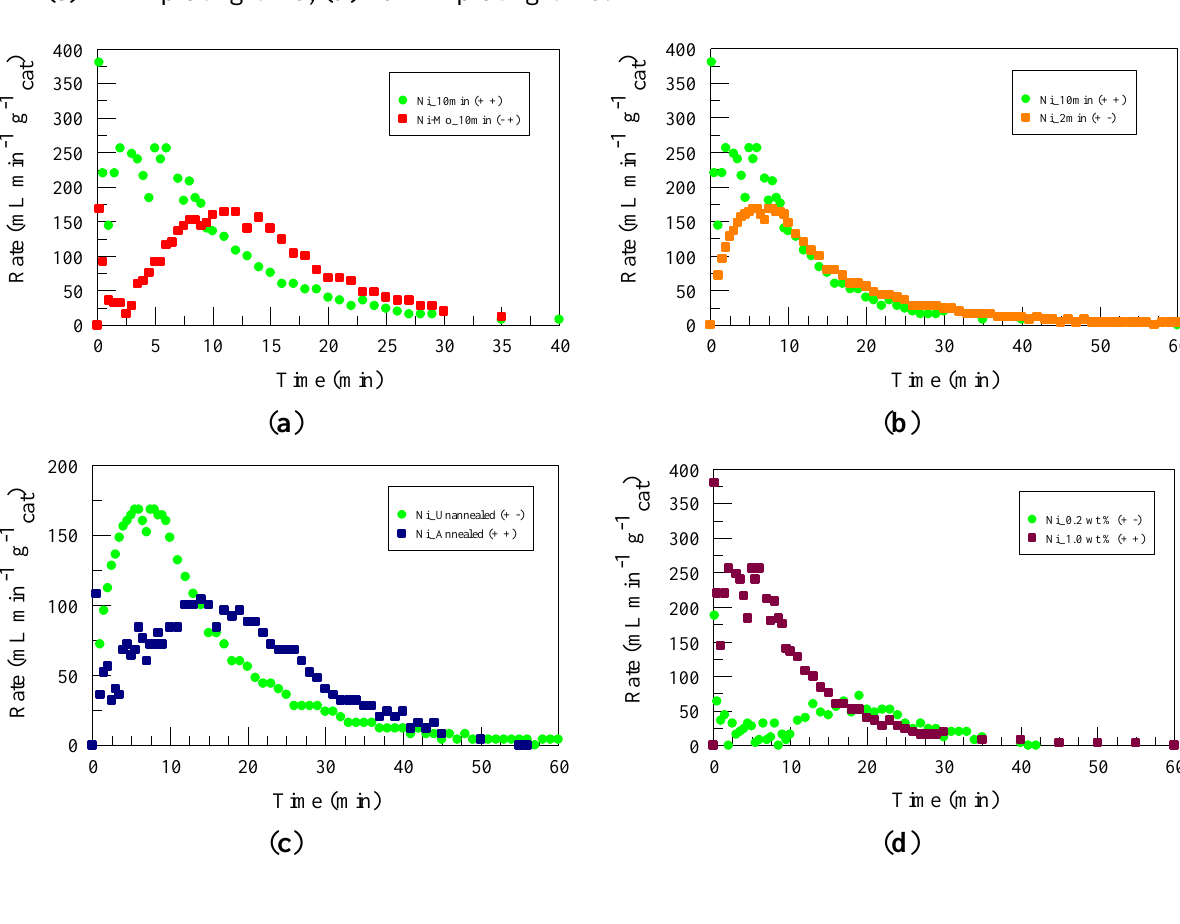
; ( b ) 1.0 wt % NaBH ; 4 4